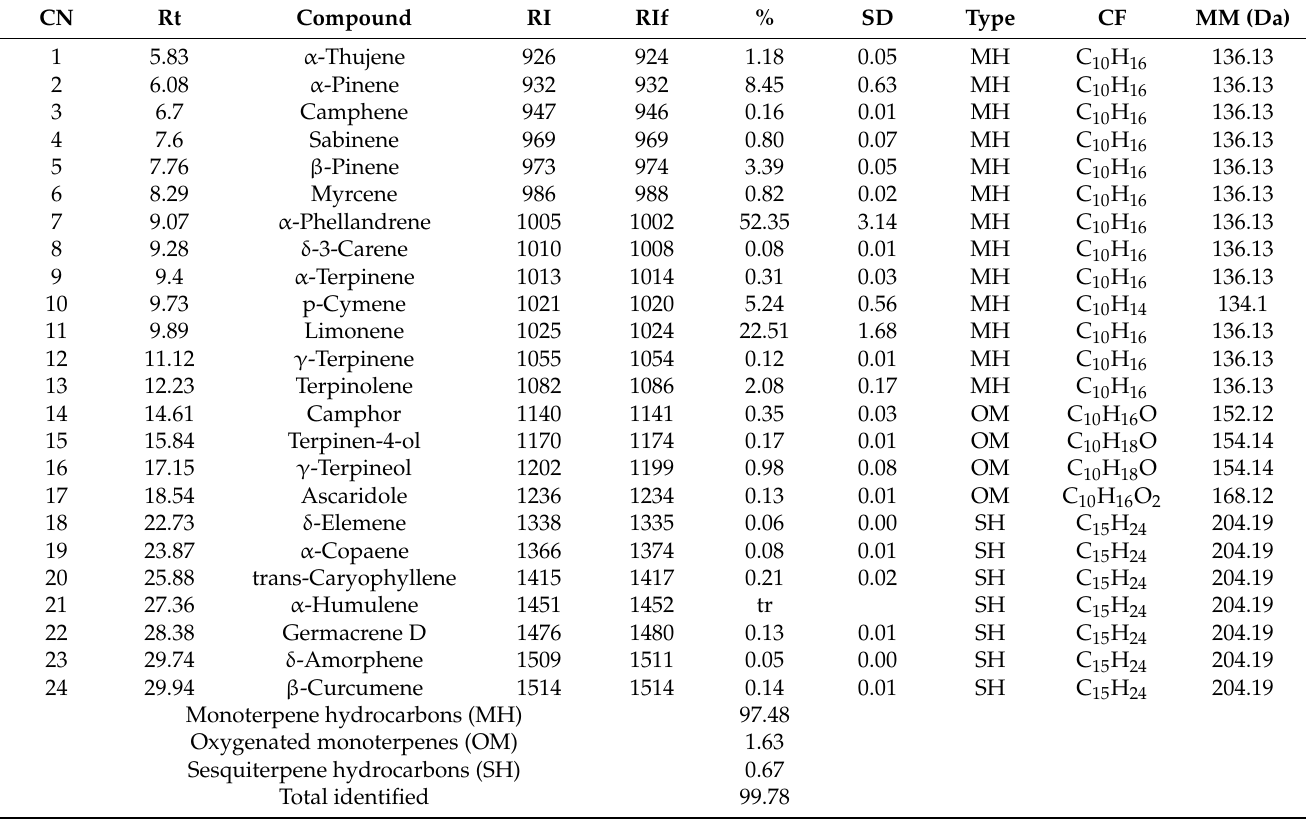
Table 1. Chemical composition of Dacryodes peruviana essential